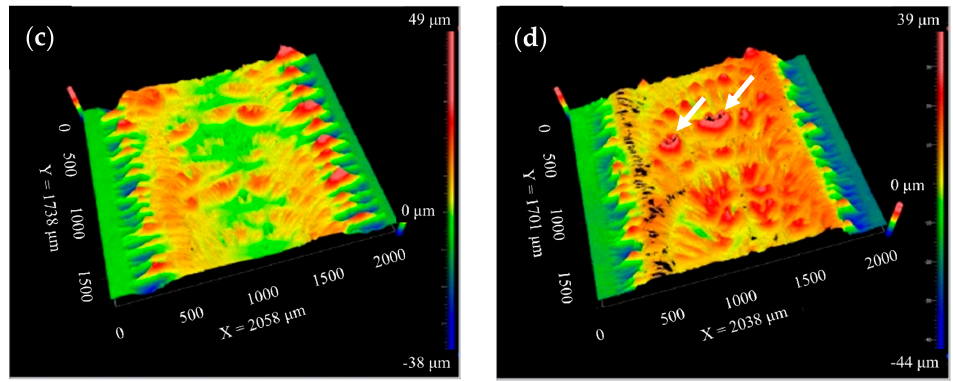
Figure 9. Comparison of LSP and conventional laser nitriding processed under similar conditions: ( a ) and ( c ) scanning electron (SE) micrograph and optical profile of top surface of laser-nitrided trail, respectively; ( b , d ) SE micrograph and optical profile of top surface of LSP-nitrided trail, respectively. The pores formed due to nitrogen expulsion from the melt pool in ( b , d ) are indicated by white arrows. Reprinted with permission from Ref. [109]. Copyright 2016 John Wiley and Sons.